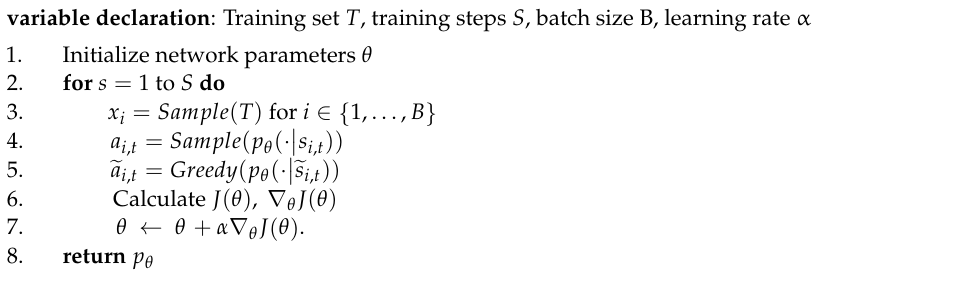
Algorithm 1 Policy Gradient